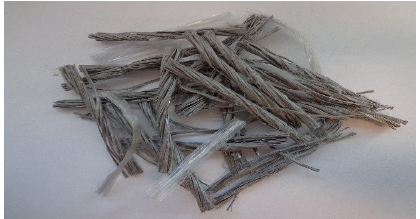
Figure 1. Synthetic structural polypropylene fibres l = 54 mm.